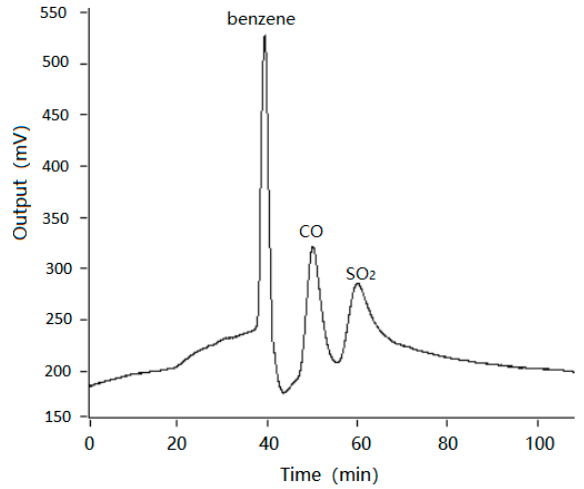
Figure 6. Chromatogram of benzene, CO, and SO 2 .